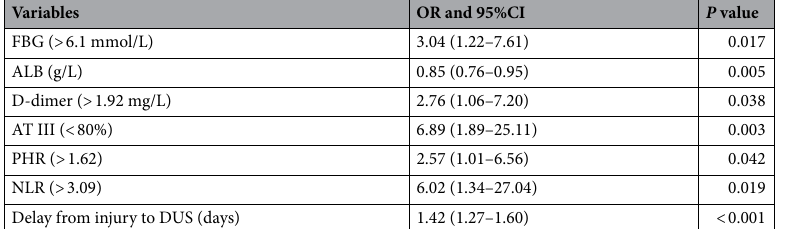
Table 2. Multivariate analyses of the risk factors related to preoperative DVTs following isolated calcaneal fracture. OR odd ratio, CI confidence interval, FBG fasting blood glucose, ALB albumin, AT III antithrombin III, PHR the platelet-to-hemoglobin ratio, NLR the neutrophil-to-lymphocyte ratio.